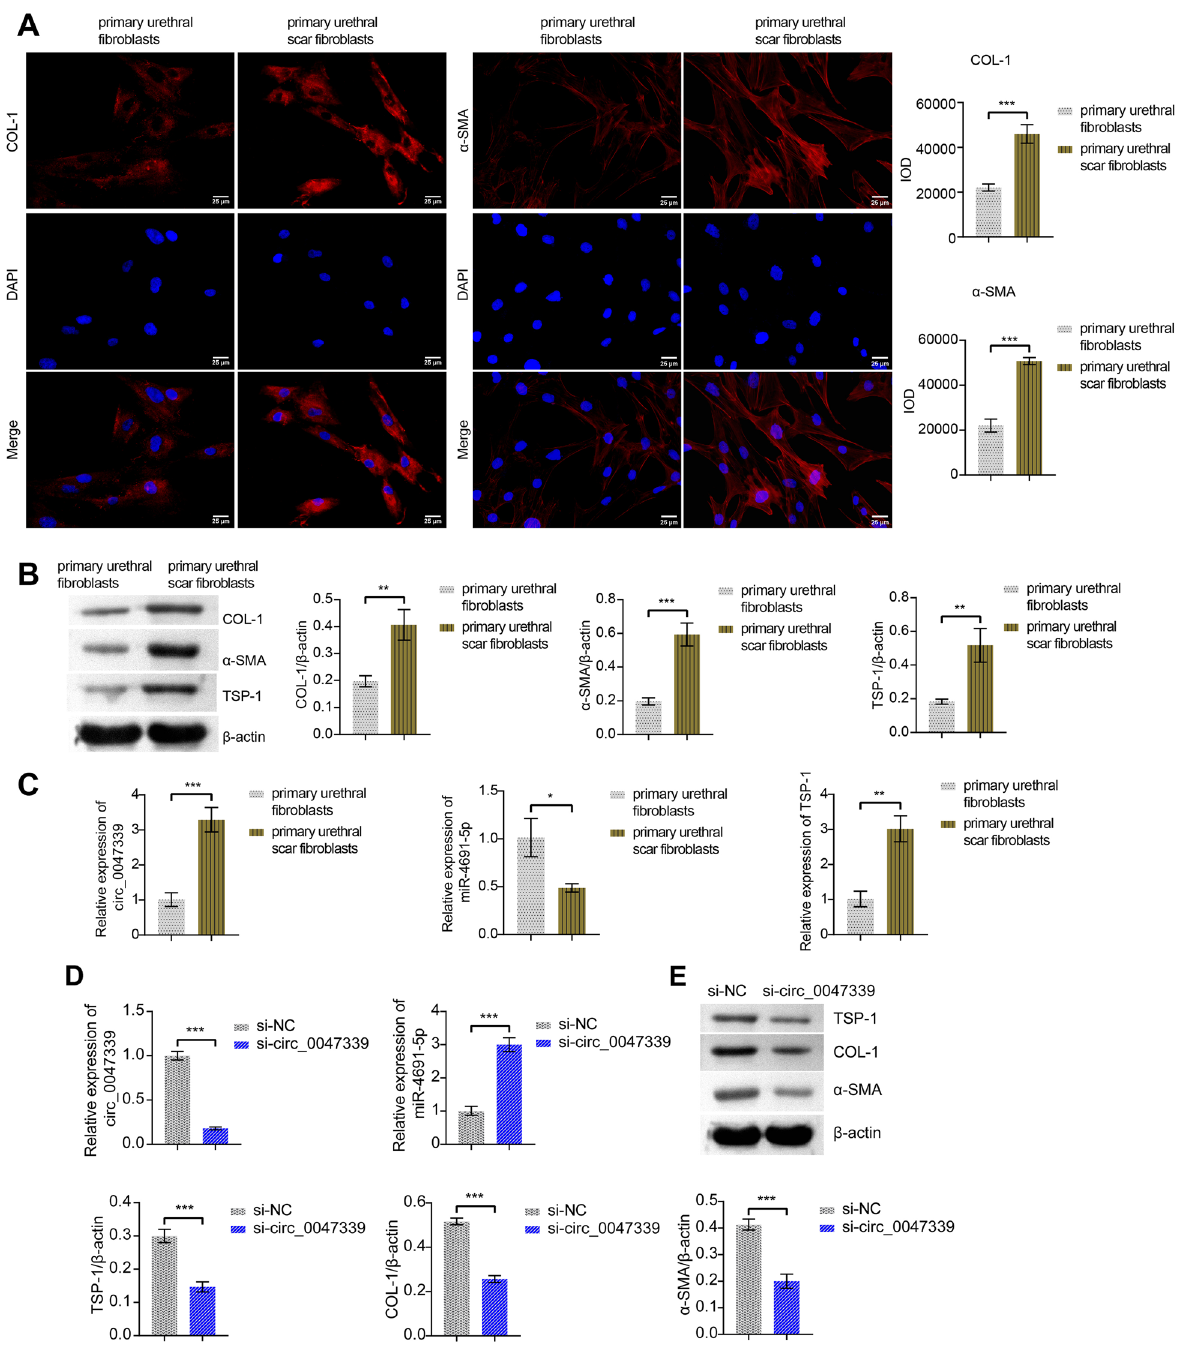
Figure 4. Circ_0047339 regulated the fibrosis of urethral fibroblasts. ( A ) The expressions of COL-1 and α-SMA were detected by IF, scale bar: 25 μm. ( B ) Western blot was conducted to determine the protein expression of COL-1, α-SMA, and TSP-1. ( C ) RT-qPCR was used to detect the expression of circ_0047339, miR-4691-5p and TSP-1. ( D ) The expression of circ_0047339 and miR-4691-5p was investigated by RT-qPCR. ( E ) Western blot was conducted to determine the protein expression of COL-1, α-SMA and TSP-1. ( F ) The expression of COL-1 and α-SMA was assessed by IF, scale bar: 25 μm. ( G ) CCK-8 was used to detect the cell viability. ( H ) EDU assay was utilized to detect cell proliferation, scale bar: 50 μm. *P < 0.05, **P < 0.01, ***P <